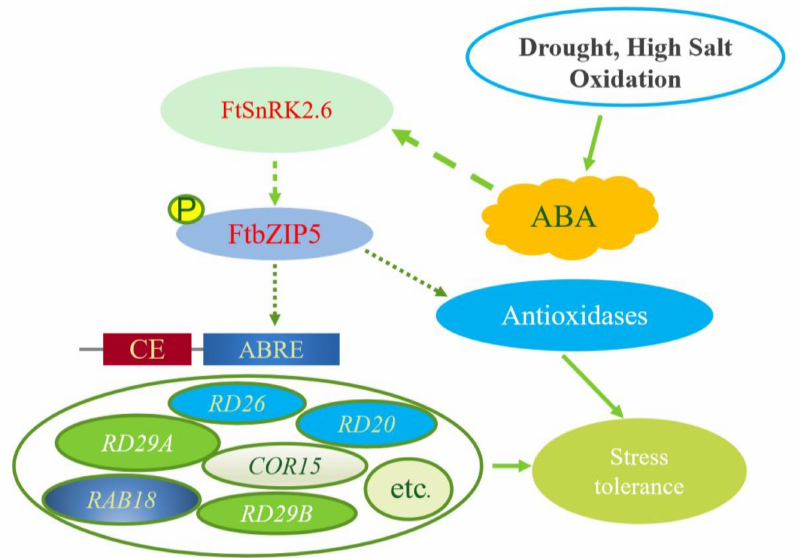
Figure 12. FtbZIP5 of Fagopyrum tataricum is involved in the ABA-dependent signaling pathway and may improve the stress tolerance of plants via the phosphorylation of FtSnRK2.6. Dotted and dashed lines indicate that the relationship between the two is not directly proved, while complete arrow lines indicate that it has been